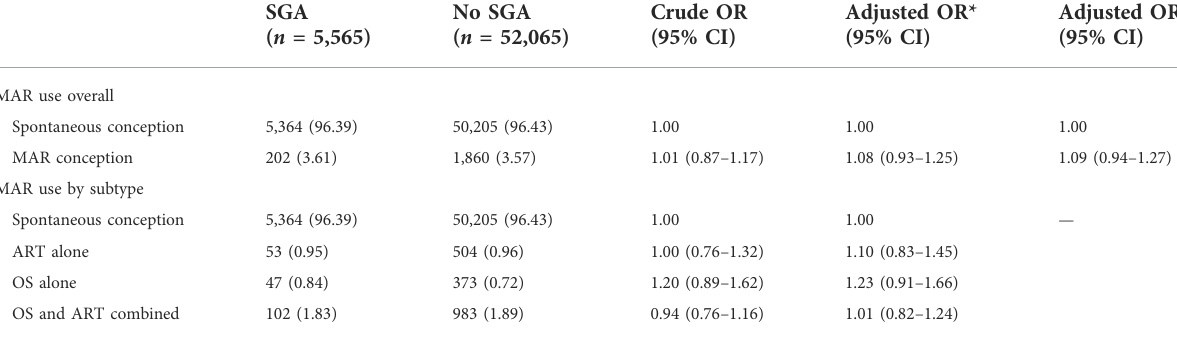
(Table 2). Furthermore, when recategorizing OS exposure as clomiphene use or other OS, we can see that the association between clomiphene, the most used OS, and SGA is the strongest when compared to SC, without reaching the desired level